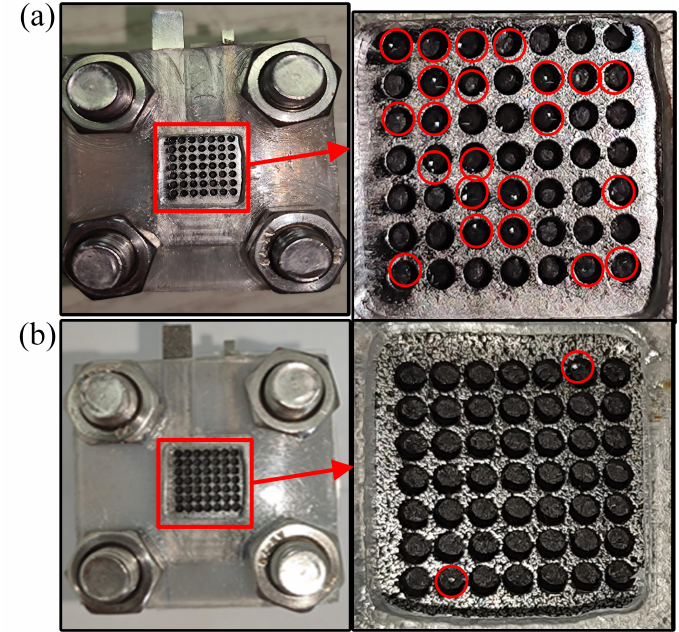
Figure 10. Flooding of the cathode. ( a ) µ DMFC of stainless steel; ( b ) µ DMFC of foamed stainless steel. The polarization curves of the foamed stainless steel µ DMFC were tested to find the optimum methanol solution concentration required for the discharge. As shown in Figure 11, the maximum power of the foam stainless steel µ DMFC can reach 15.5 mW at a methanol solution concentration of 4 mol/L. Therefore, the methanol solution selection is 4 mol/L. Additionally, to perform a long and stable discharge of the µ DMFC with different gradient wettability CCC, the current density selection is 80 mA/cm 2 , and the discharge time selection is 150 min [32].